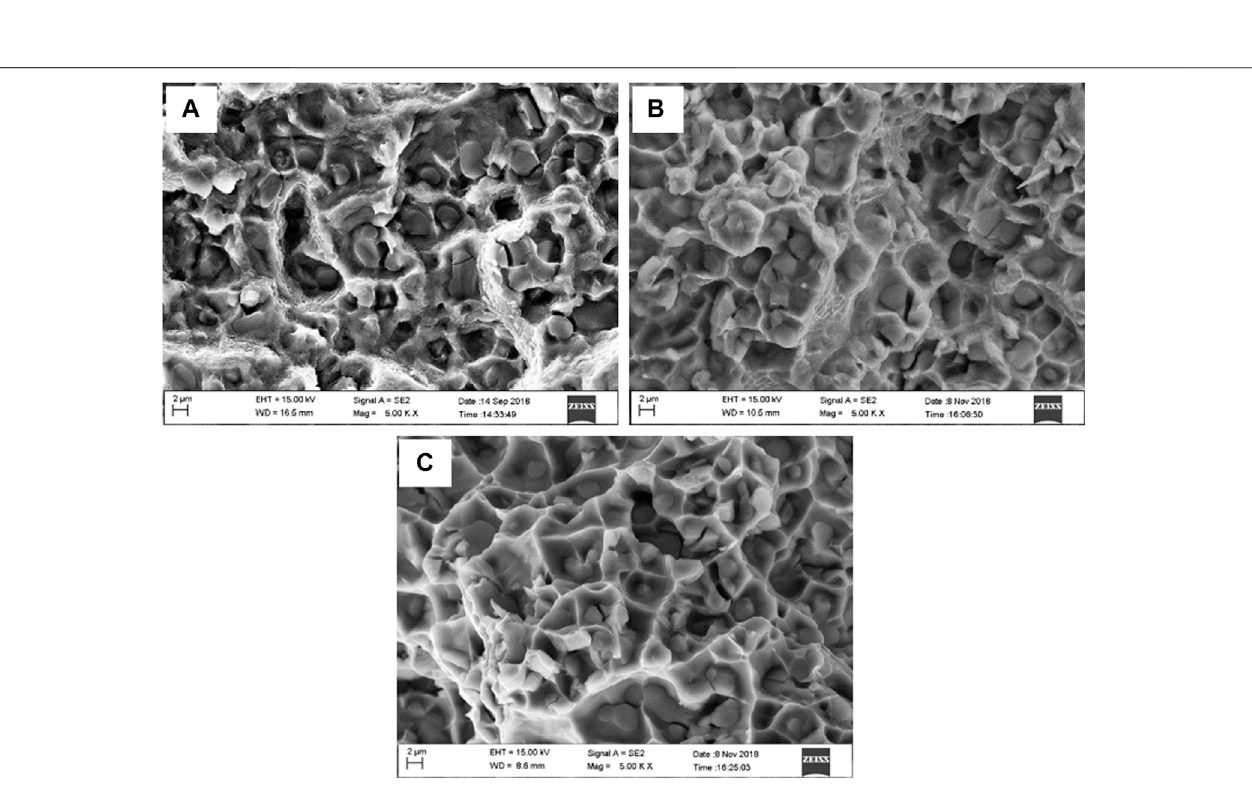
FIGURE 9 | Final fracture zone of the alloy in different conditions and stress amplitudes, (A) T1-160 MPa, (B) T4-180 MPa, (C) T6-180 MPa.